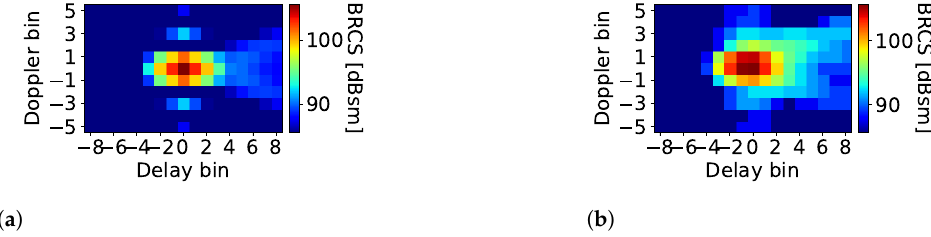
Figure 12. Comparison between DDM generated by the forward model and CYGNSS. The DDM is over Yanco, Australia. ( a ) SSBM DDM. ( b ) CYGNSS DDM. The ground positions of each delay Doppler bin, within the 3 × 5 box, are shown in